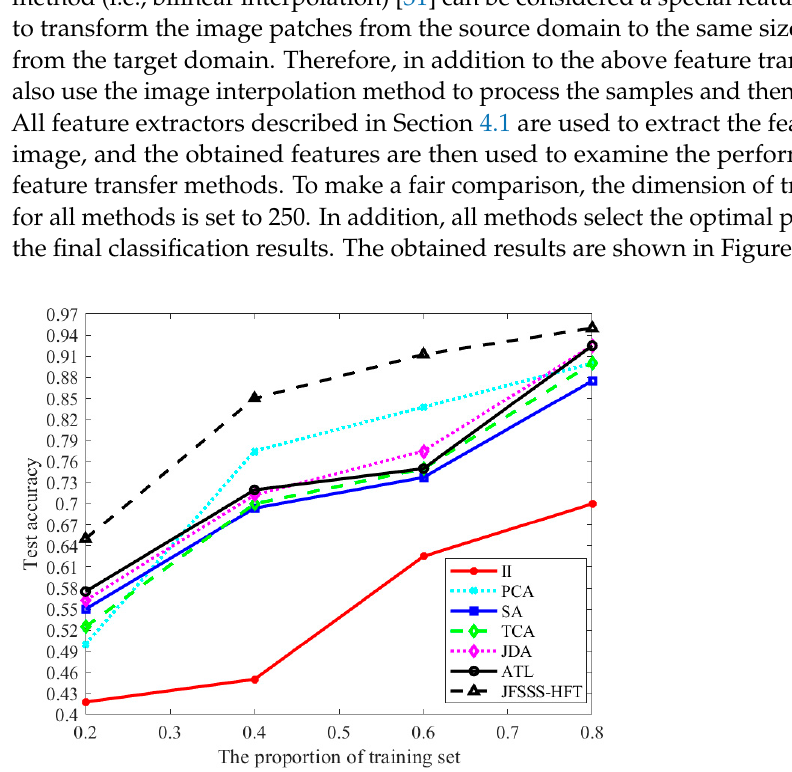
Figure 7. Classification results of different features transfer methods using training set with different sizes of dataset 1.